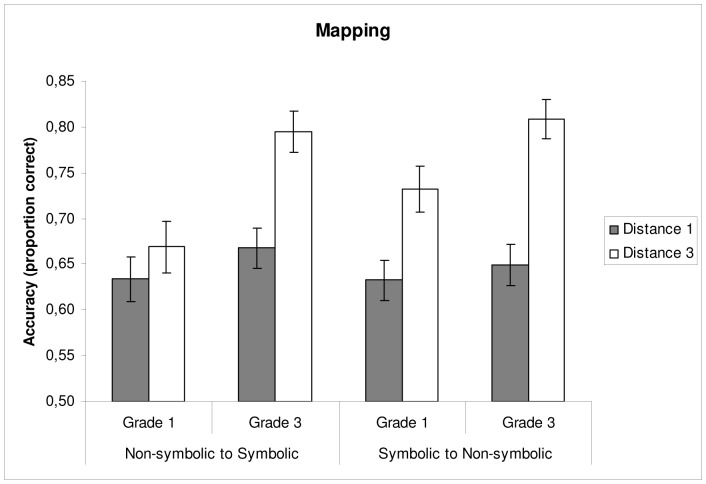
Mean accuracy on the mapping tasks as a function of grade and distance.Error bars depict 1SE of the mean.